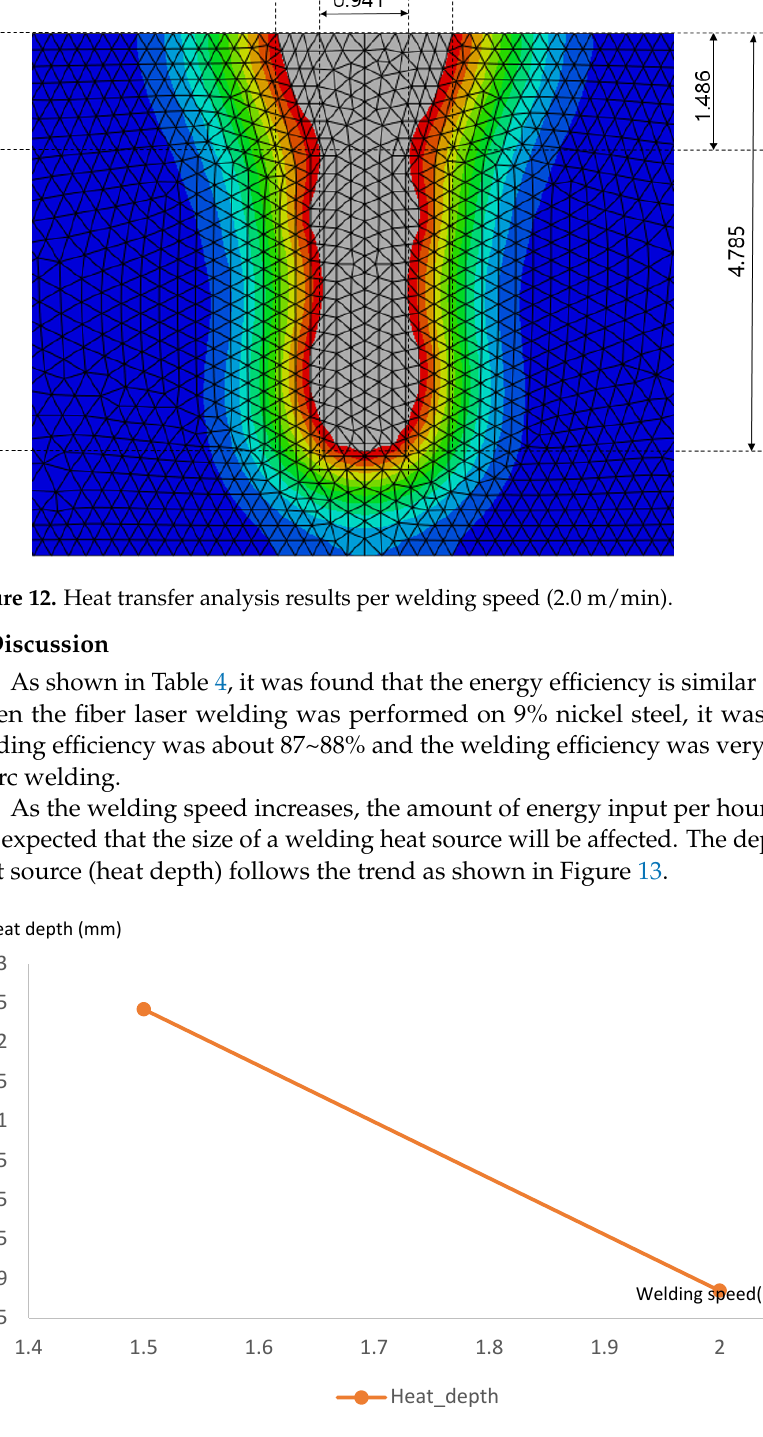
Figure 13. Heat depth tendency per welding speed.